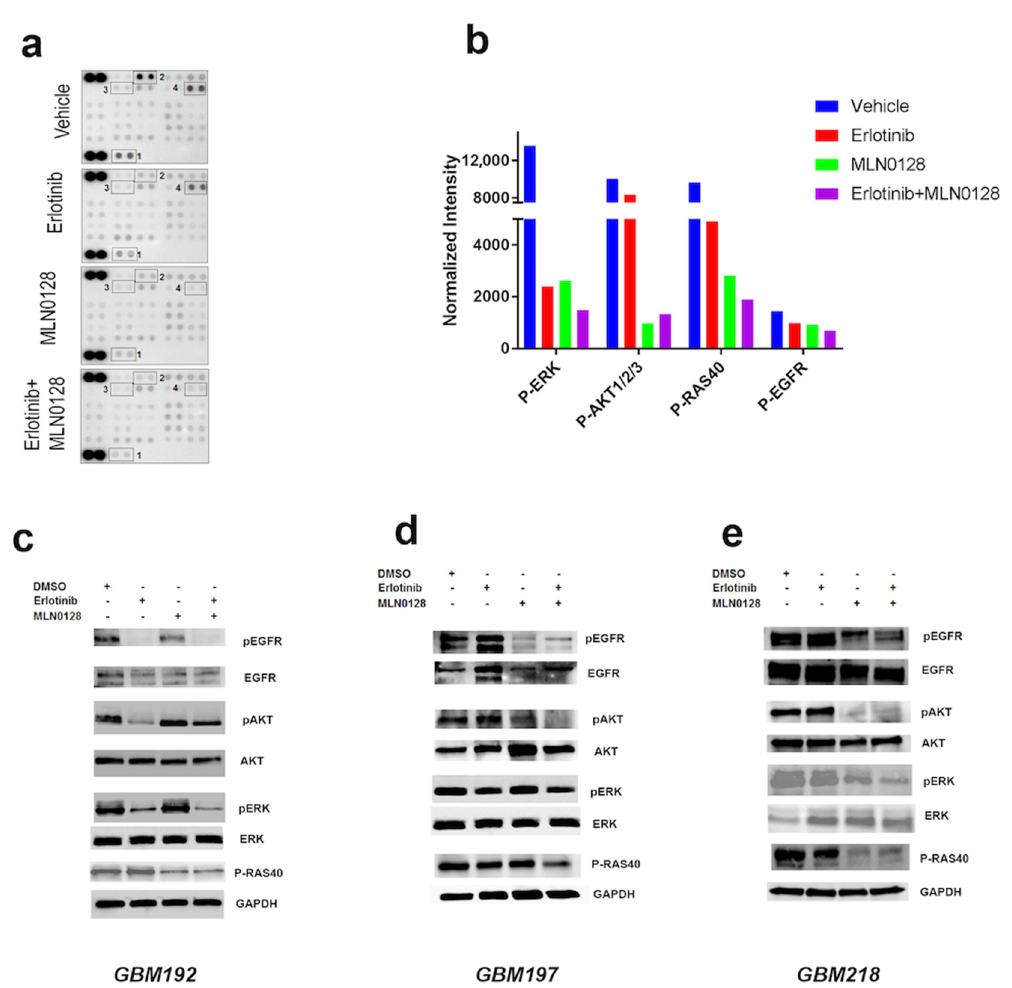
Figure 2. Erlotinib and MLN0128 treatment synergistically impacts growth-promoting pathways in EGFR-driven GBMs. ( a ) Antibody array with 45 cellular phosphor-kinases was used to detect pathways impacted by erlotinib and MLN0128. GBM192 cells were treated with erlotinib (20 µ M), MLN0128 (1 µ M), or the combination of the two drugs for 24 h. The arrays were scanned and quantified, using the control (darkest spots) for normalization. 1 -p-ERK; 2 -p-AKT, 3 -p-Ras40, 4 -p-EGFR. ( b ) Quantification of the levels of phosphokinases under each treatment condition. Units represent normalized densitometry values. ( c – e ) Western blot analyses of the same phosphoproteins were performed in PDXCs from GBM192, GBM197, and GBM218 treated with vehicle (DMSO), erlotinib, MLN0128, or the combination of the two drugs and probed with the indicated antibodies. GAPDH was used to control for equal protein loading.